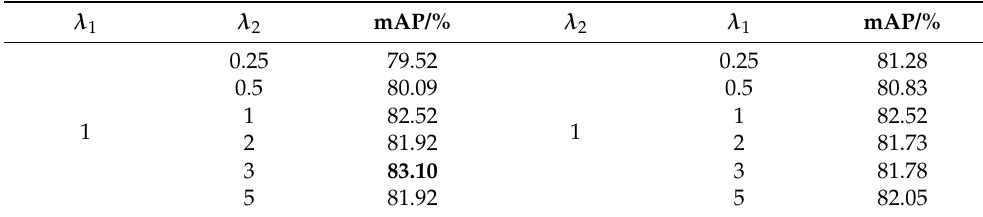
Table 5. Effect of loss weight of each branch on dual branch network performance.